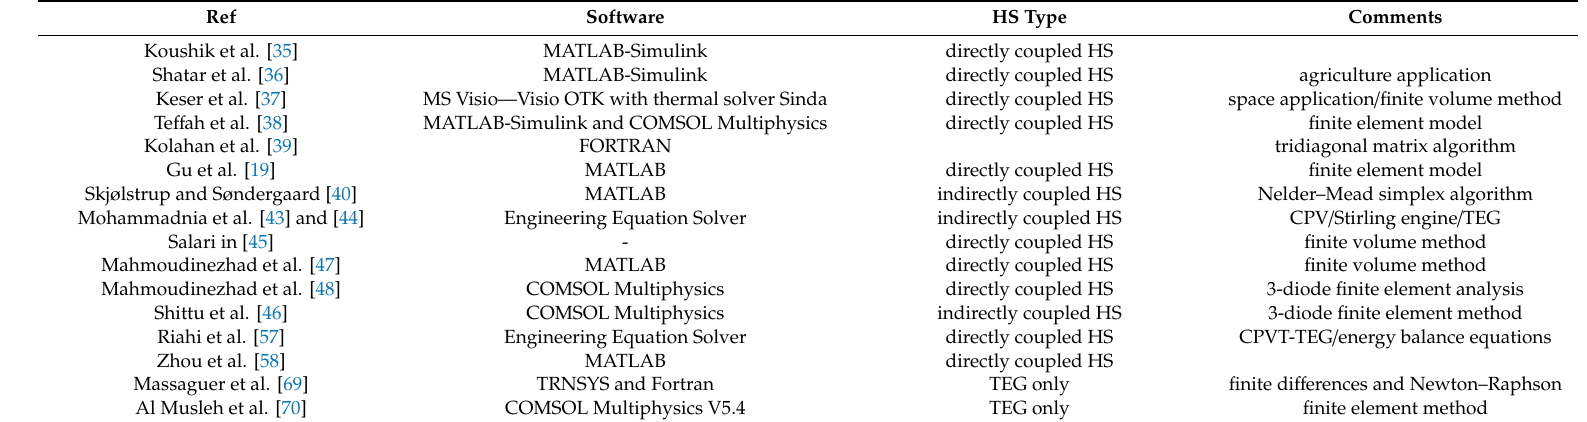
Table 2. Software and methods for numerical analysis of